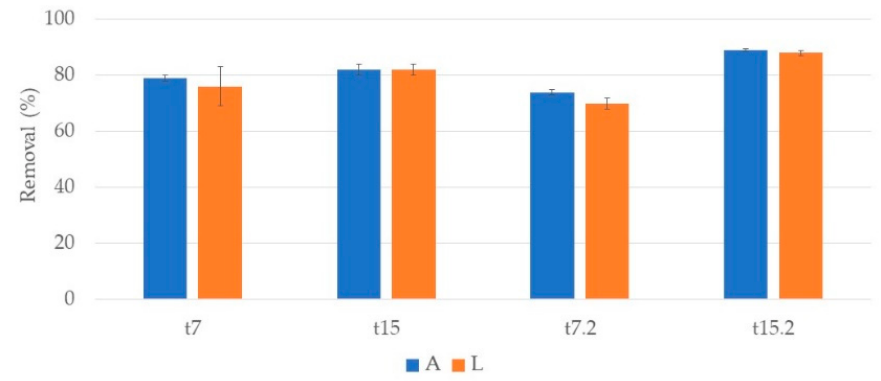
Figure 11. Removal percentage and respective standard deviation (n = 3) of COD, in CWs with P. australis and expanded clay (A) or lava stone (L) over the two cycles of treatment. First cycle: samples taken after one week (t7) and at the end of the two ‐ week cycle (t15). Second cycle: samples taken after one week (t7.2) and at the end of the two ‐ week cycle (t15.2).